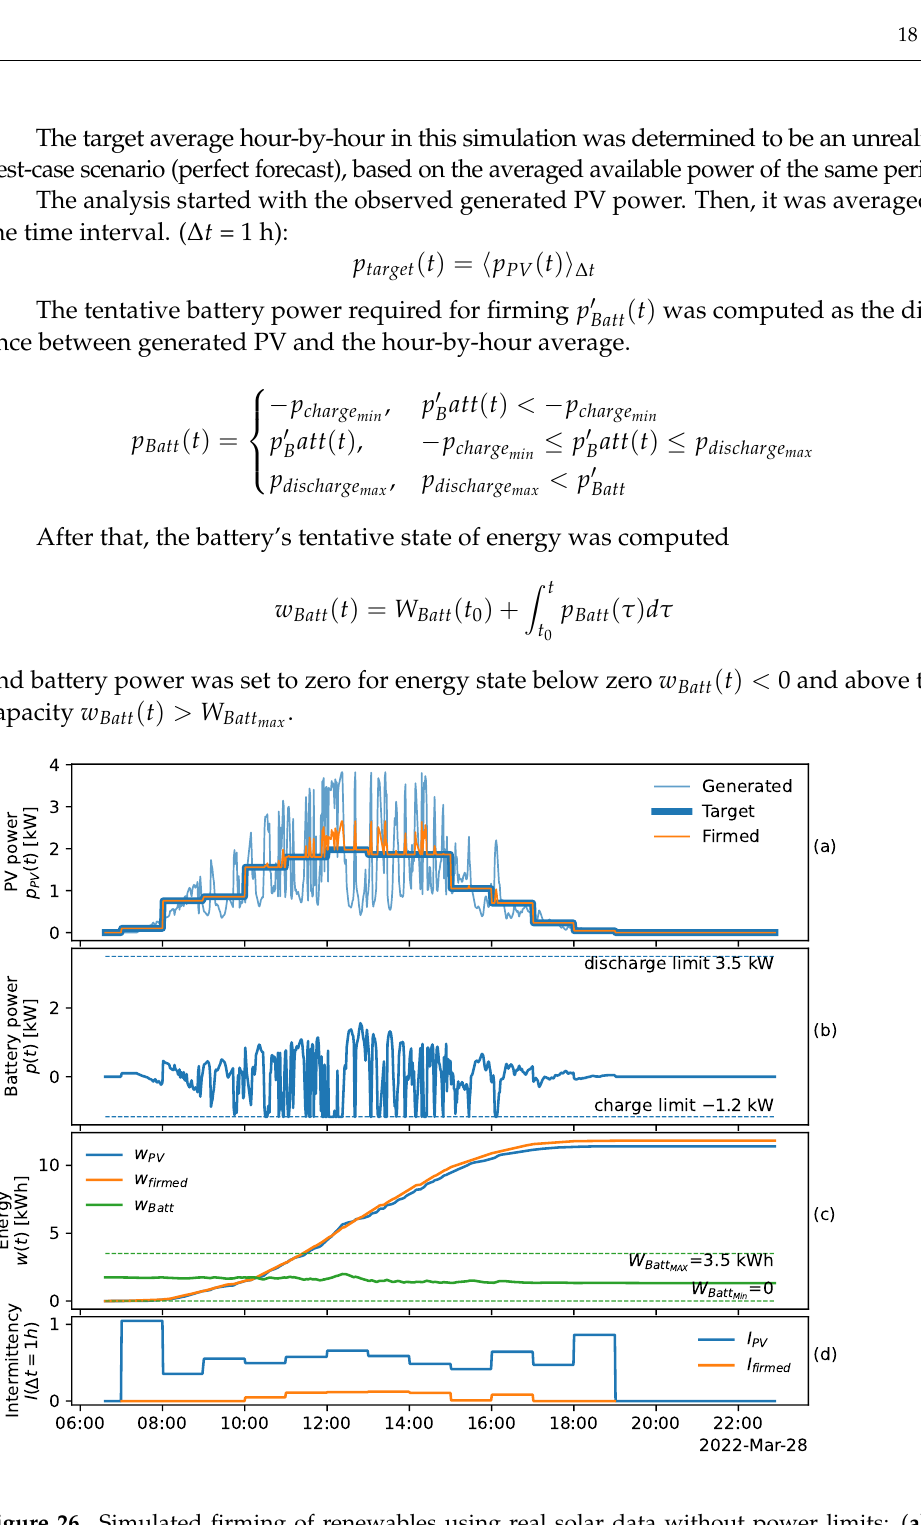
Figure 26. Simulated firming of renewables using real solar data without power limits: ( a ) PV generation with significant intermittency; ( b ) battery power and its limits; ( c ) battery energy and generated energy; ( d )